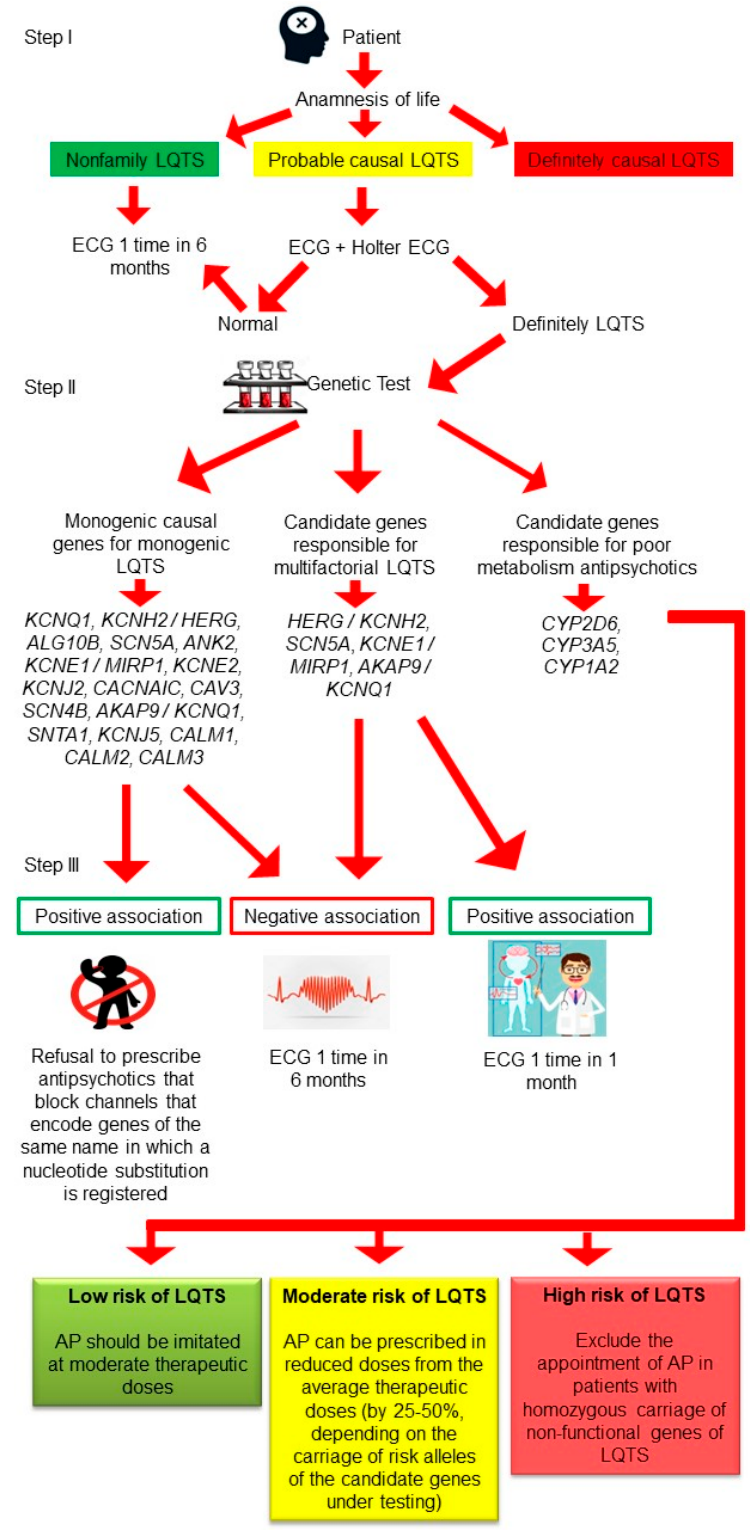
Figure 13. Algorithm for diagnosing the risk of developing long QT syndrome (LQTS) in schizophrenic patients requiring treatment with antipsychotics (APs). Note: ECG—electrocardiogram; IM—intermediate metabolizer; PM—poor metabolizer; UM—ultrarapid metabolizer.